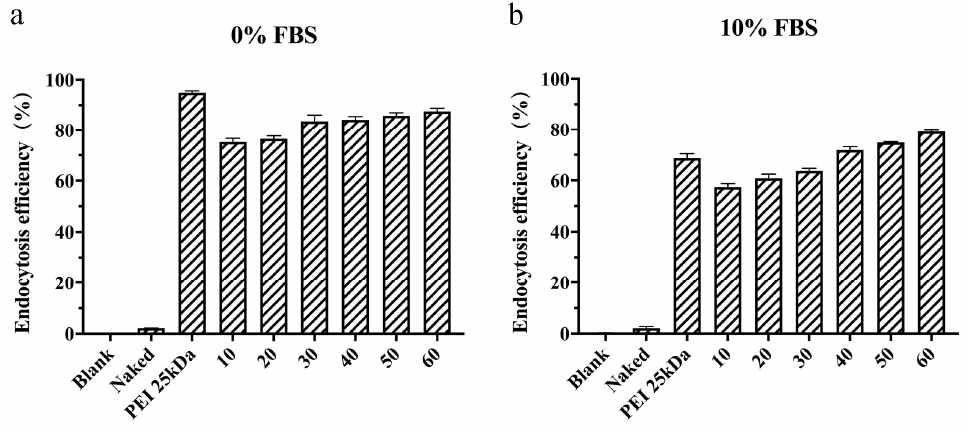
Figure 6. Endocytosis efficiency of TFSPEI polyplex incubated for 4 h at different w / w ratios (10, 20, 30, 40, 50, 60) with ( a ) 0% FBS and ( b ) 10% FBS. Data are shown as the mean ± S.D. (n = 3).